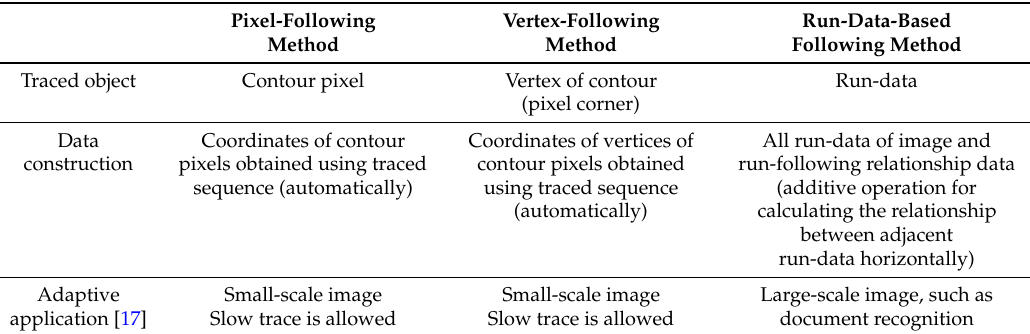
Table 1. Comparison of contour-following